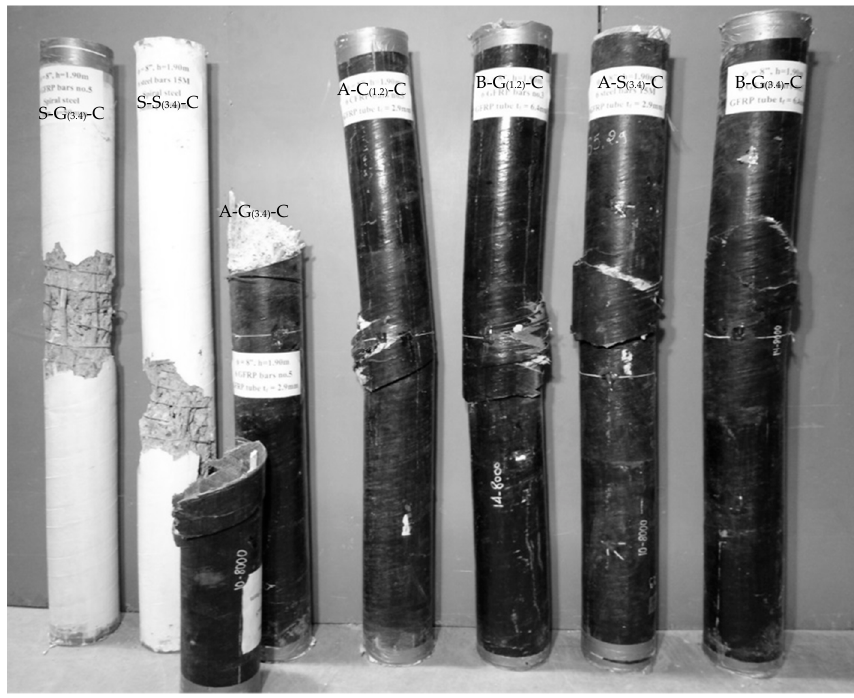
Figure 9. Overall failure modes of tested specimens.